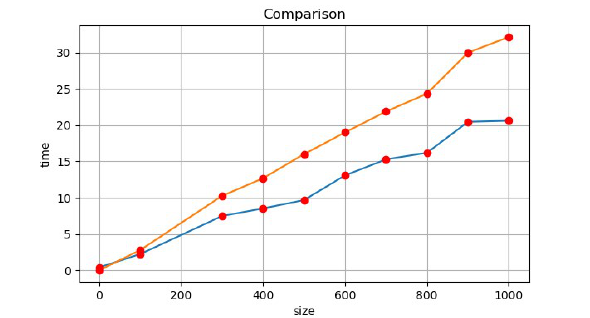
Figure 3. Comparison of calculation results Figure description: The magnitude of the abscissa data unit: ten thousand. The ordinate size unit: second.